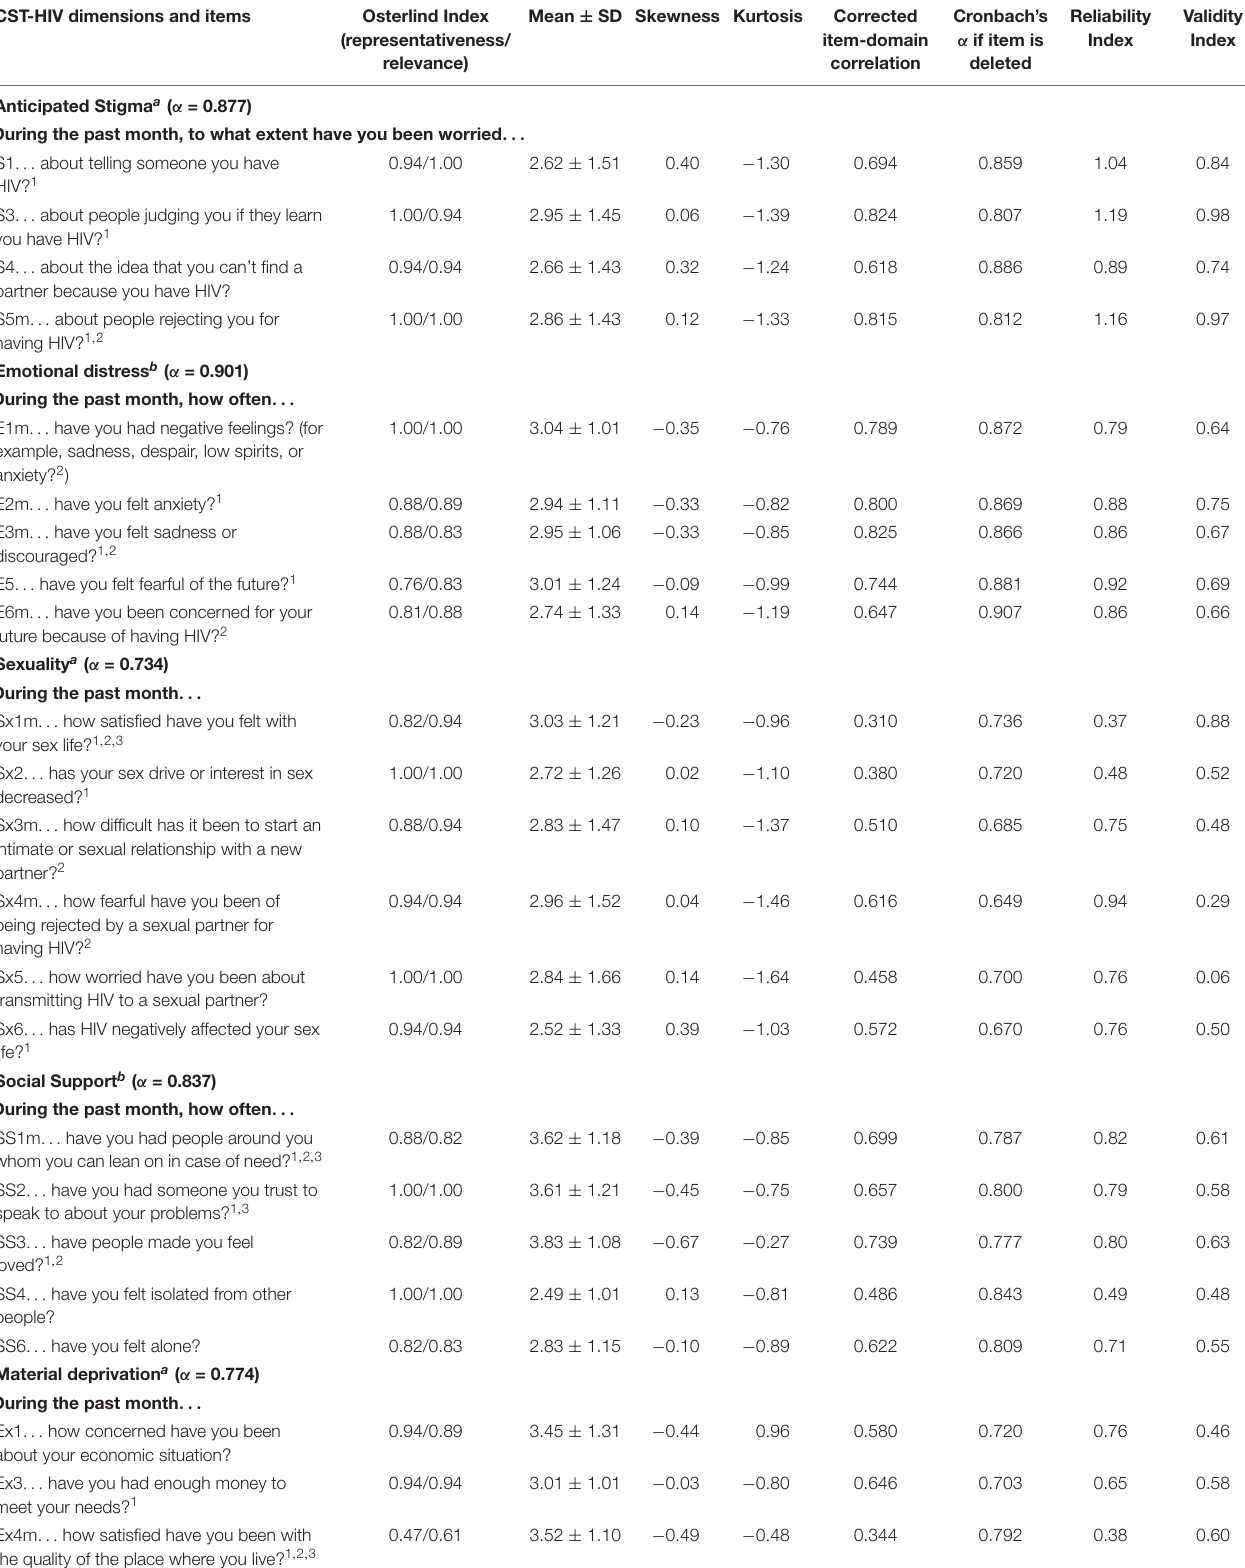
TABLE 3 | Psychometric properties of the initial pool of items of the CST-HIV. CST-HIV dimensions and items Osterlind Index